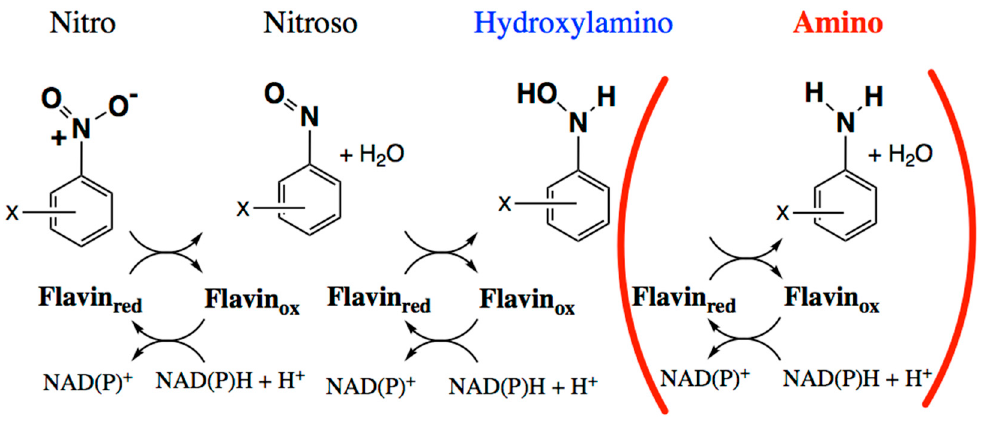
Figure 1. Biochemical reduction of nitroaromatic groups in sequential two-electron steps mediated by nitroreductase-related (NR-related) superfamily members [11,12,22]. The first two reductions appear general whereas the third appears more occasional and its occurrence is not as well understood [29].